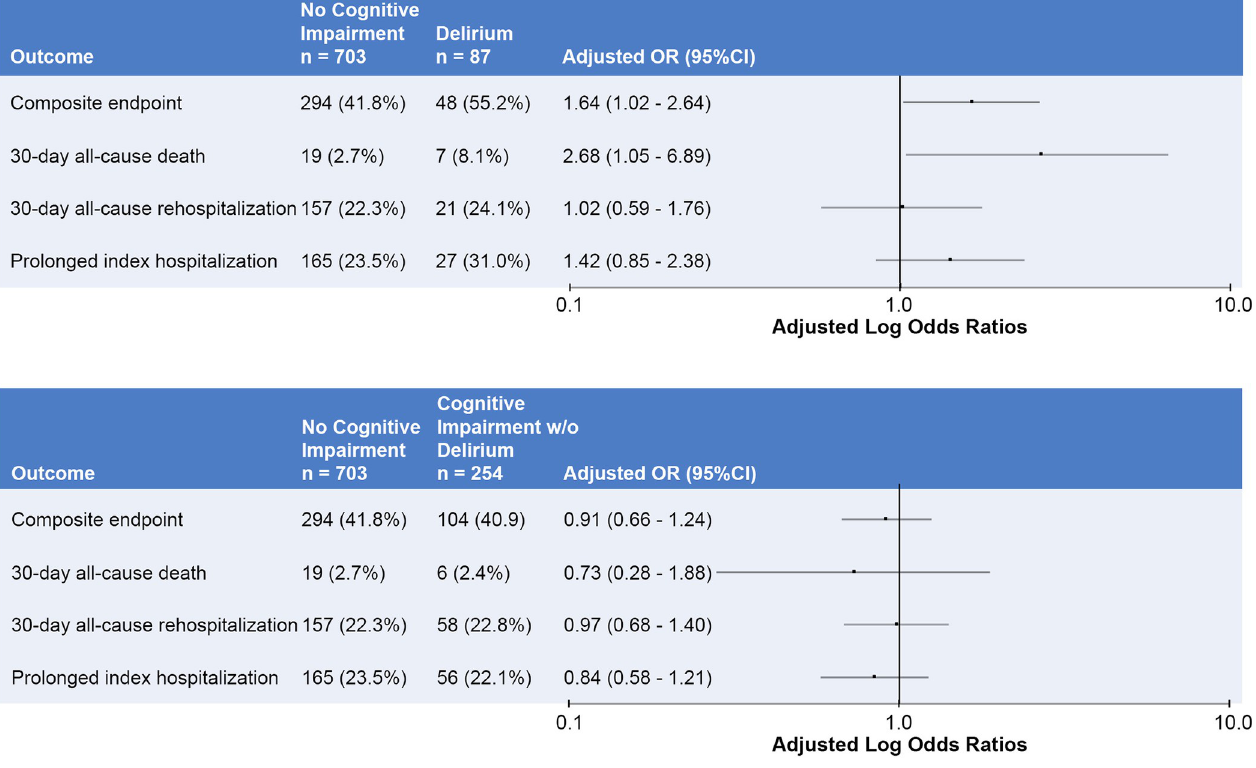
Fig 2. Proportion of patient outcomes within each cognitive impairment category. � p-value < 0.05. #, P-value < 0.10.